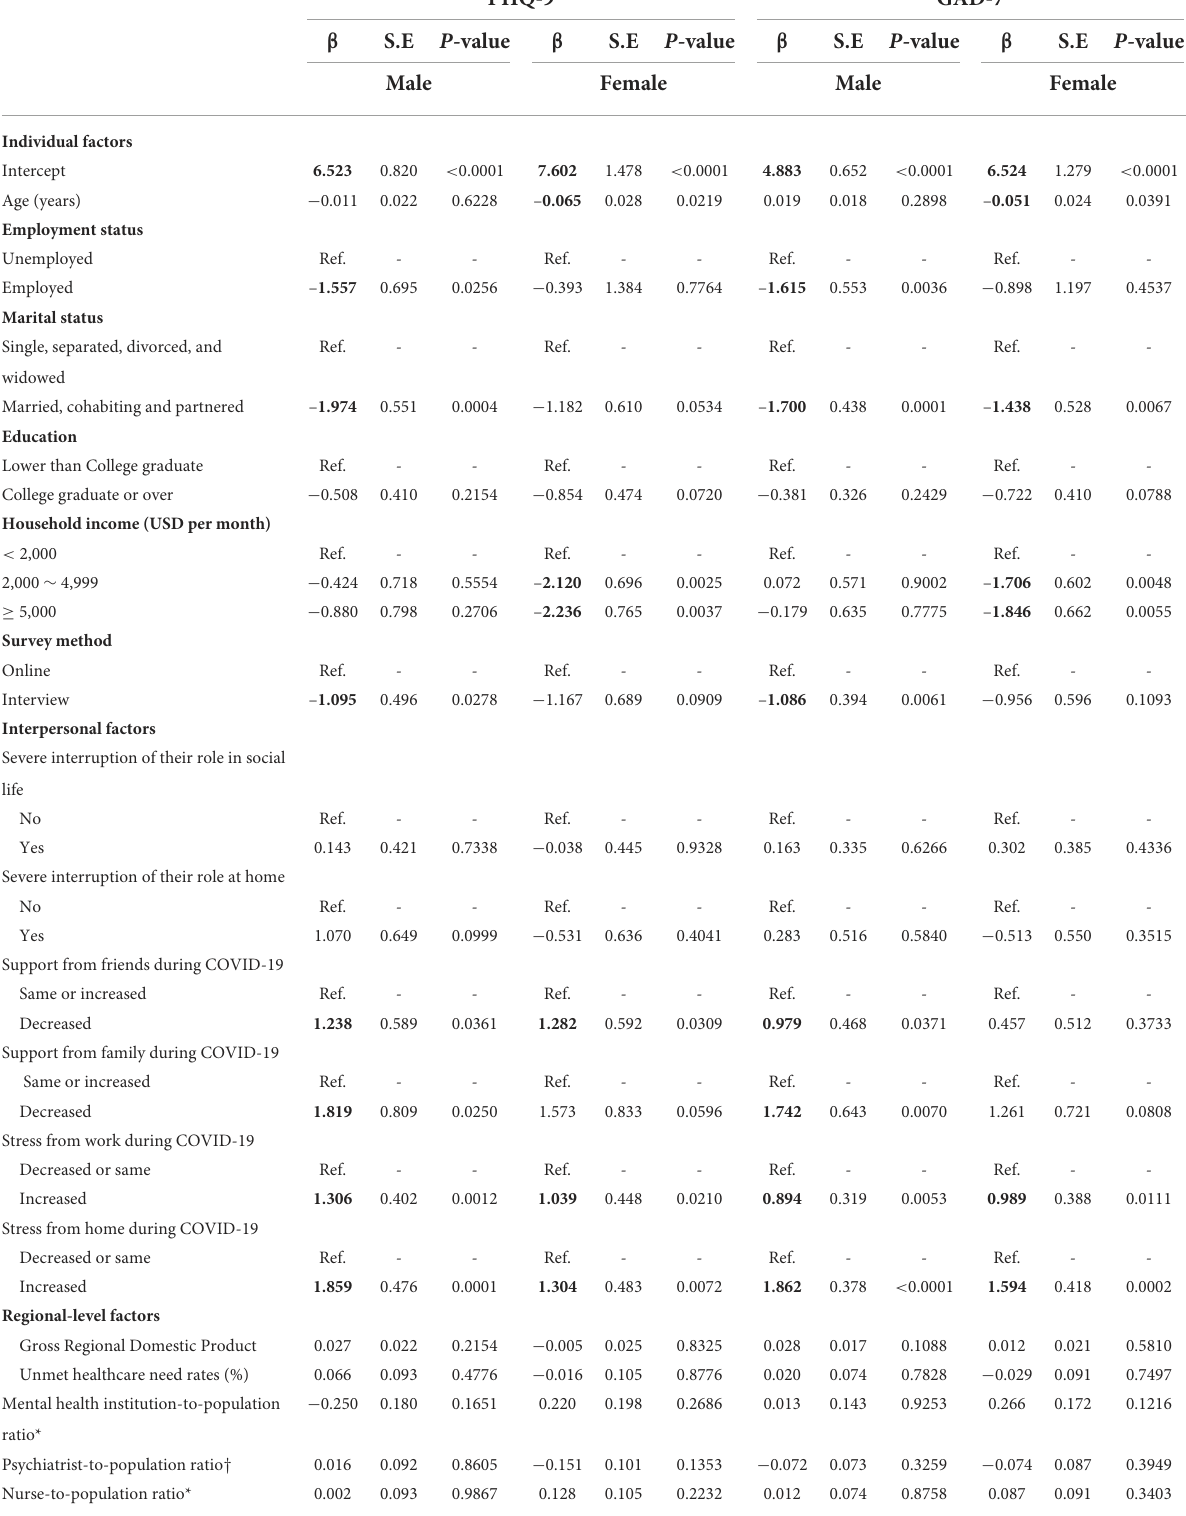
TABLE 4 Subgroup analysis of multiple linear regression for the effect of individual and community factors on mental health status by